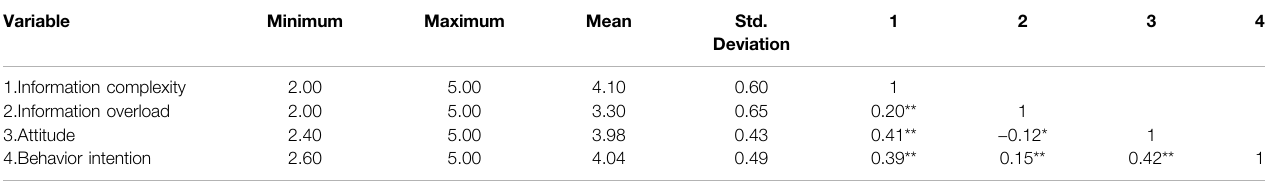
TABLE 1 | Descriptive statistics and correlation analysis of information overload and attitude between information complexity and behavior intention. Variable